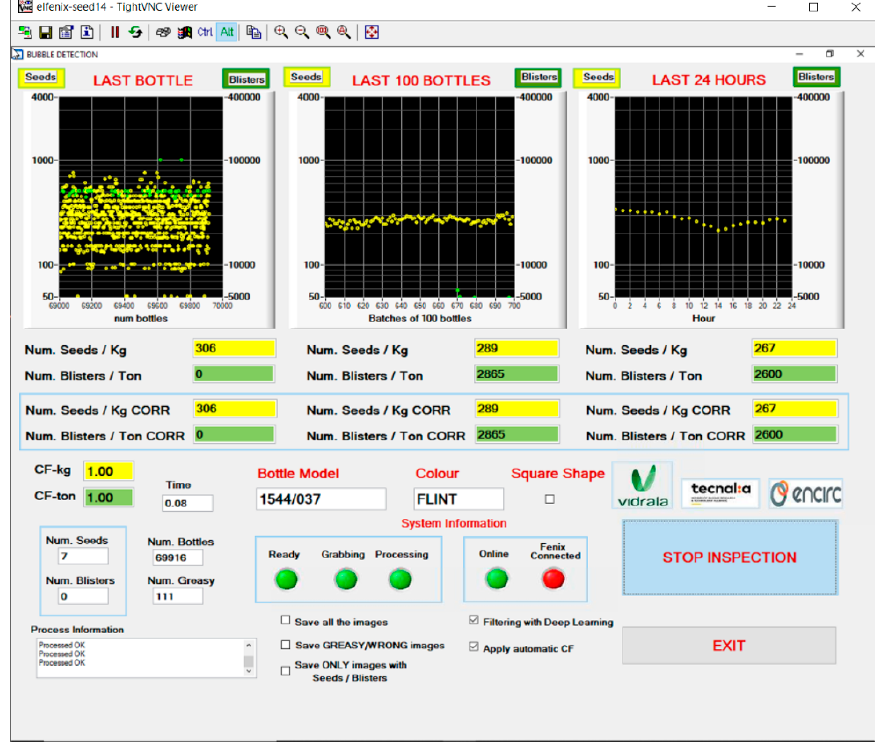
Figure 12. Main panel of the user interface of the application.